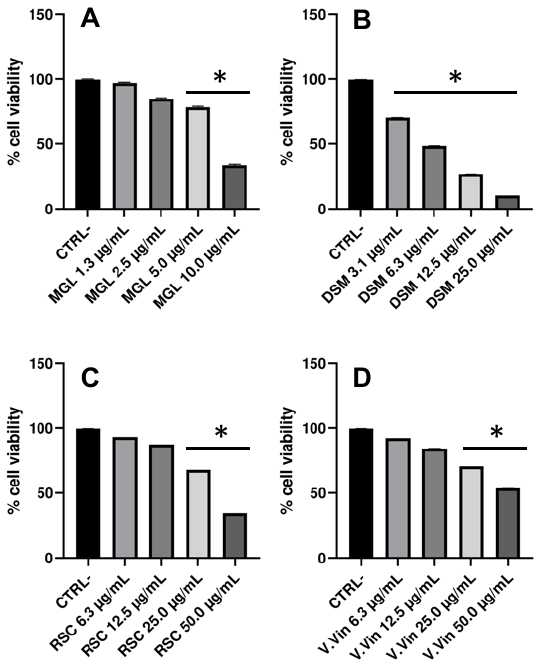
Figure 2. HUVECs viability measured by MTT assay (Mean ± SEM of 6 independent measurements) following different treatments with each compound and extract selected: the viability of HUVEC cells after a 24 h incubation with different concentrations of magnolol (MGL) (1.3, 2.5, 5.0, 10.0 μg/mL) ( A ); diosmetin ( DSM) (3.1, 6.3, 12.5, 25.0 μg/mL) ( B ); R. aculeatus root extract (RSC) (6.3, 12.5, 25.0, 50.0 μg/mL) ( C ); and V. vinifera seeds extract (V.Vin) (6.3, 12.5, 25.0, 50.0 μg/mL) ( D ). In all the panels, CTRL- represents the negative control, consisting of HUVECs incubated with the cell medium for 24 h. * p < 0.05 vs. CTRL-.